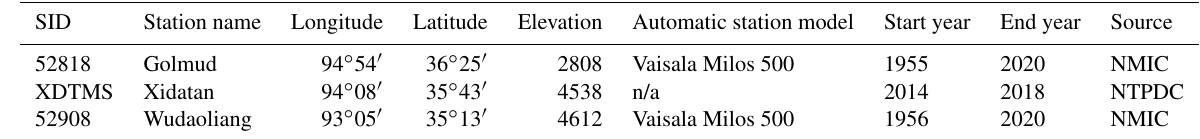
Table 1. List of meteorological observation data, where n/a indicates not applicable. Automated observations were conducted at the Golmud and Wudaoliang stations in 2000 and 2001, respectively.